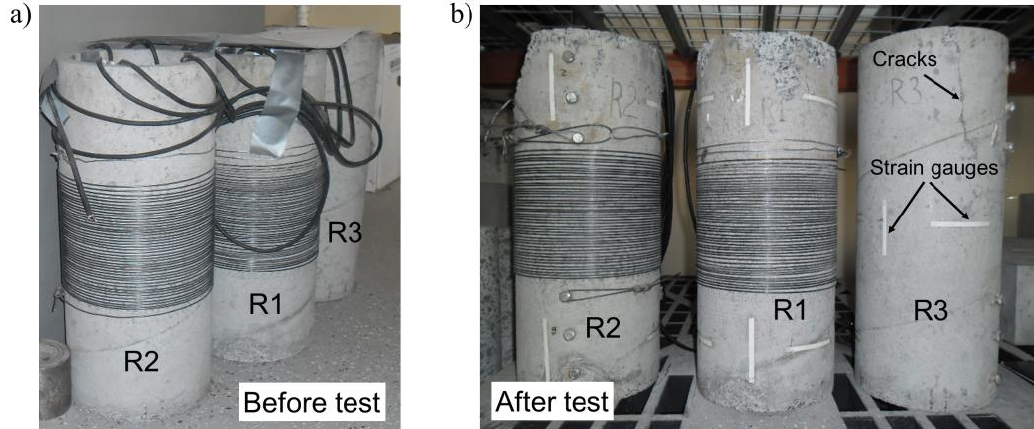
Figure 5. Pictures of the hollow concrete cylinders.